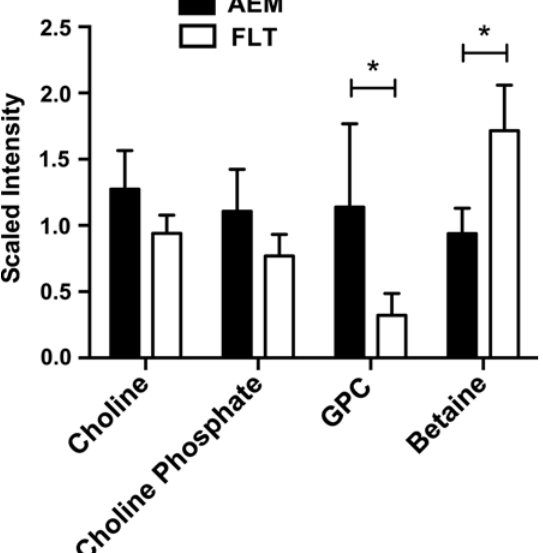
Fig 1. Betaine levels are increased in FLT mouse livers. Mass spectrometry-based metabolomics was performed on n = 6 mice per group as described in Methods and Materials. Mass spectra corresponding to choline and related metabolites were identified and extracted chromatographic peaks used for relative quantification. Mann-Whitney analysis of results showed a significant increase in levels of betaine in FLT mice as compared with AEM controls, with a concomitant decrease in concentrations of metabolic precursors. * P < 0.05; data are mean ±